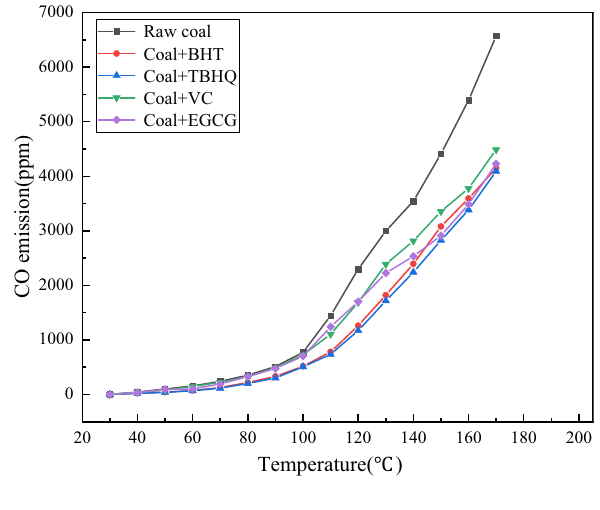
Figure 2. Concentration of CO released from coal samples with